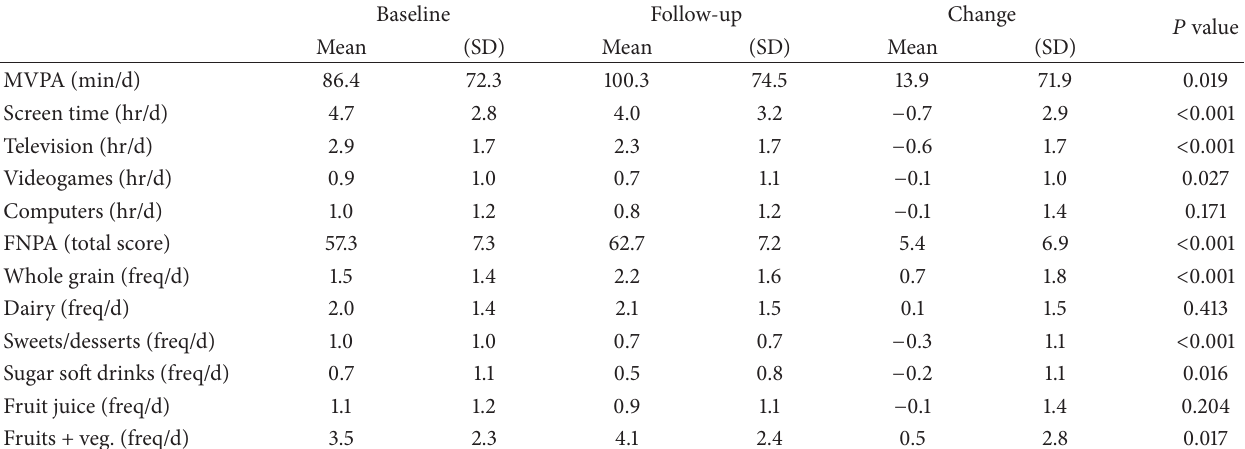
Table 5: Health behavior changes among youth who completed FitKids360.